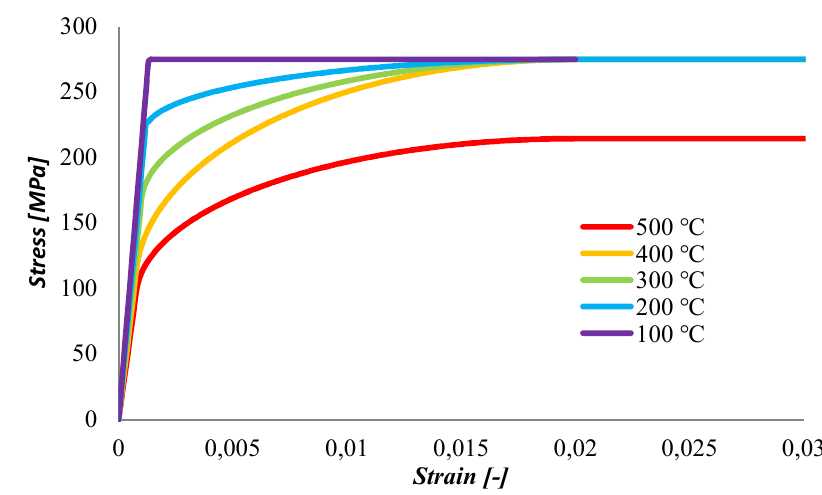
Figure 2. Stress-strain relationship for steel S275 Figure 2. Stress–strain relationship for steel